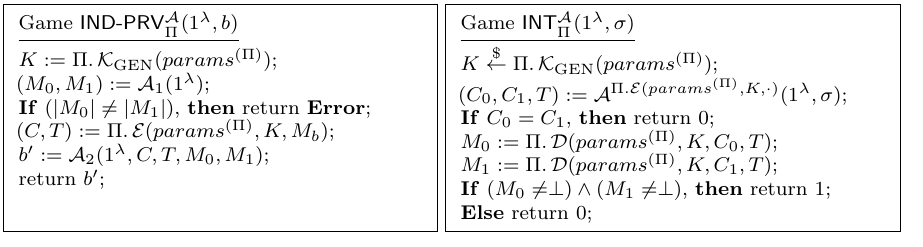
Figure 2: Games defining IND-PRV and INT security of AE scheme Π